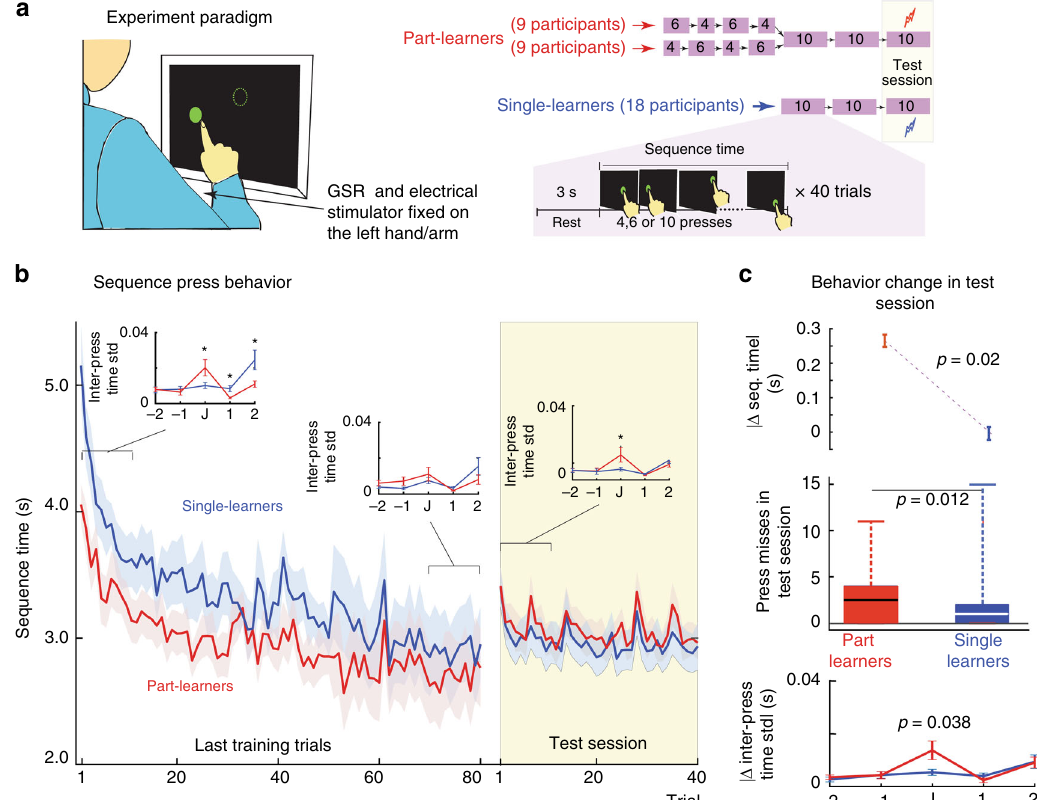
Fig. 1 Experiment 1. a The participants learnt to press a sequence of circles that appeared one after another on a computer screen in front of them. As part learners, they trained on the fi rst six or four circles in a sequence before training on the remaining circles (see right panel). They then went on to train on the whole 10-circle sequence and fi nally took an anxiety test on the sequence. Single learners trained only on the whole 10-circle sequence before taking the anxiety test. All sessions included 40 sequence trials. b The press sequence time through the last training trials (white background) and the anxiety test session (yellow background) for part learners (red trace) and single learners (blue trace). The shaded area represents the across participant standard error. The inset fi gures show the local variation in the standard deviation in the inter-press time aligned with the junction “ J ” (either after the fourth or sixth circle in a ) of the pre-learnt sequences by the part learners. For single learners, J was chosen either after the fourth or sixth circle randomly. Asterisk show a difference in the inset fi gures that is signi fi cant ( p < 0.05). c The change of participant behavior in the anxiety test session. The across participant change in the sequence press time is shown in the top panel. The average number of times participants pressed a wrong circle and received an electrical shock in a test session are shown in the middle panel. On each box of the boxplot, the line within the box shows the median, the edges of the box are the 25th and 75th percentiles of the data, and the whiskers show the range of the data points. The change in the inter-press time standard deviation (STD) between the fi rst 20 test trials and the last training session is shown in bottom panel. Error bars in the fi gure represent standard error. All p values represent paired one- sample tests. We checked for the normality of the datasets using the Shapiro – Wilk test before each comparison. To get the p -values a t -test was used for comparisons when the data groups were normal, and a Wilcoxon signed rank test were used when one or both of the datasets were non-normal (see text for